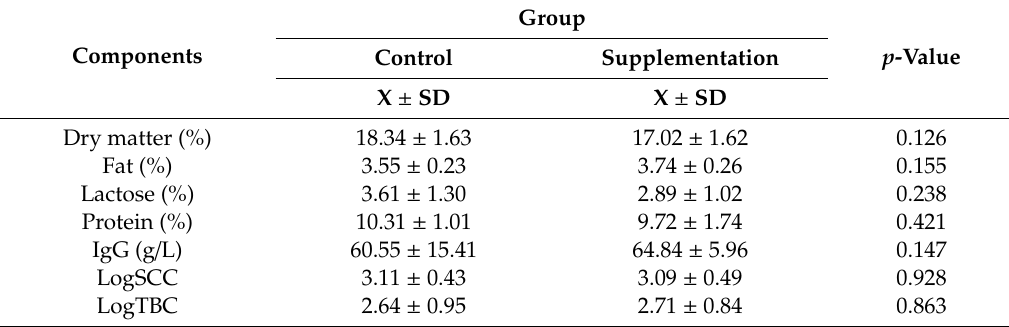
Table 2. The basic composition (mean ± SD), somatic cell count, total bacteria count and IgG concentration in colostrum from Charolaise cows assigned to control (n = 10) and supplementation (n = 10; diet supplemented with soy lecithin) group. Components